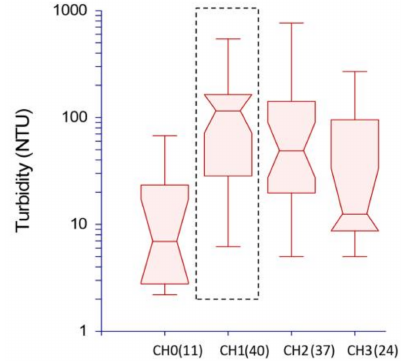
Figure 7. Turbidity response at Chelten Hills by logger. The turbidity response for each logger was plotted and analyzed with ANOVA. Logger CH 0 was found to have a statistically lower turbidity response than loggers CH 1 and CH 2 but no statistical difference from other loggers. Numbers in parentheses indicate the number of storms included in the